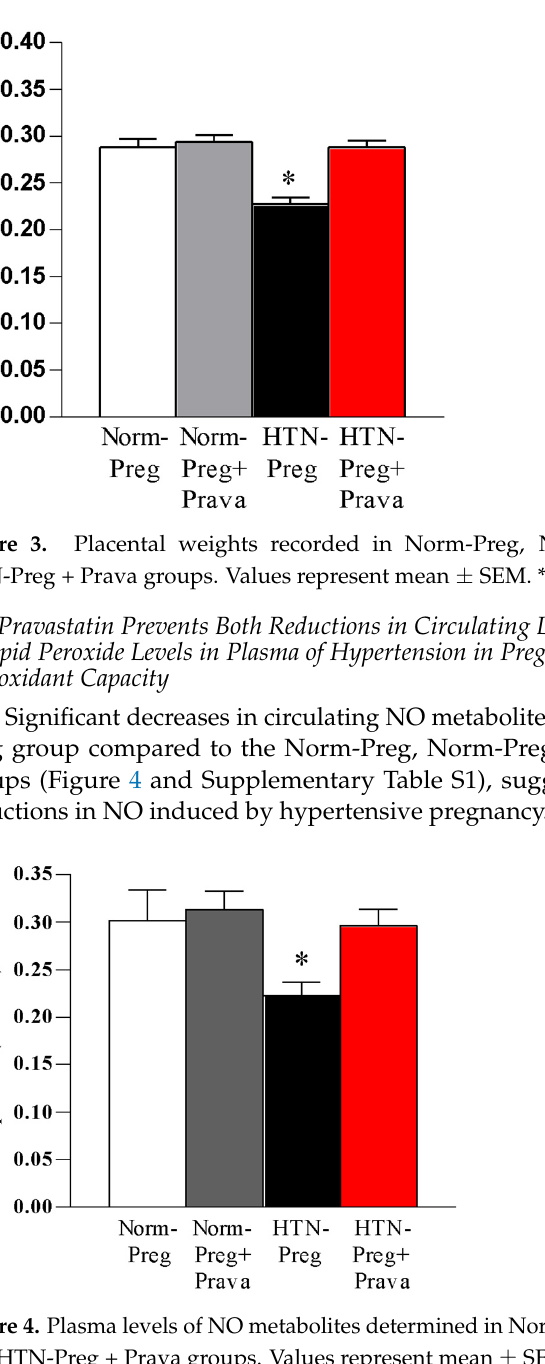
Figure 2. Li tt er size recorded in Norm-Preg, Norm-Preg + Prava, HTN-Preg, and HTN-Preg + Prava groups. Values represent mean ± SEM.